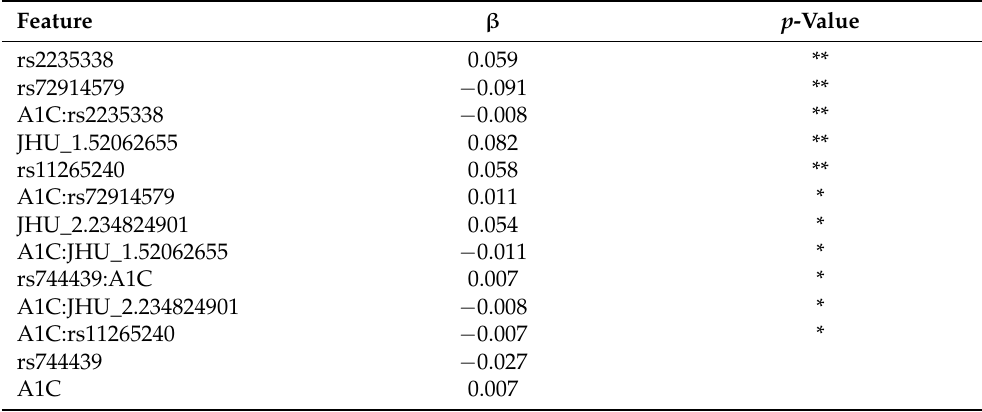
Table 8. Association estimates for features in final multivariate GxE regression model for cg19693031 methylation.